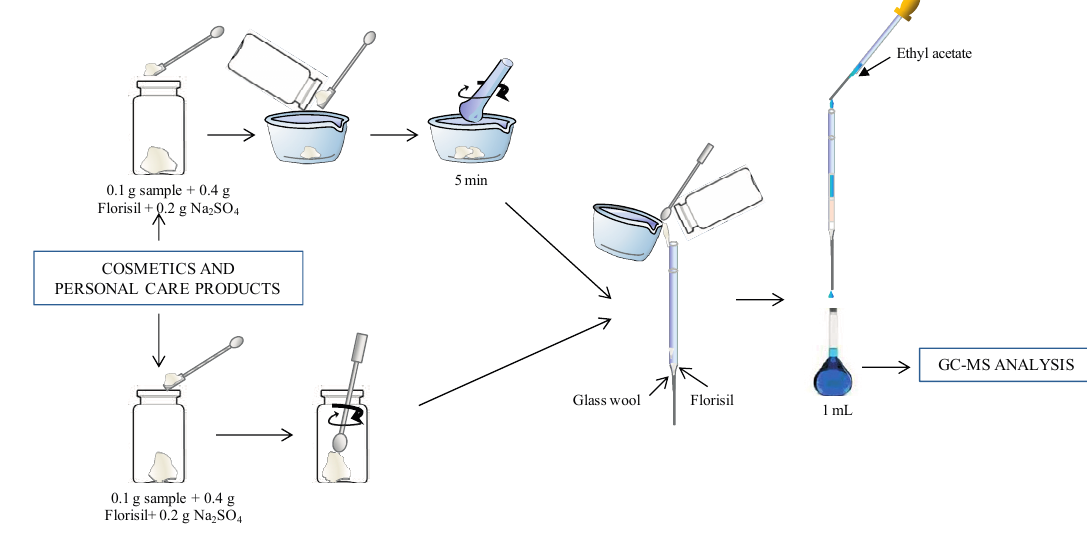
Figure 1. Micro-matrix-solid-phase-dispersion (MSPD)